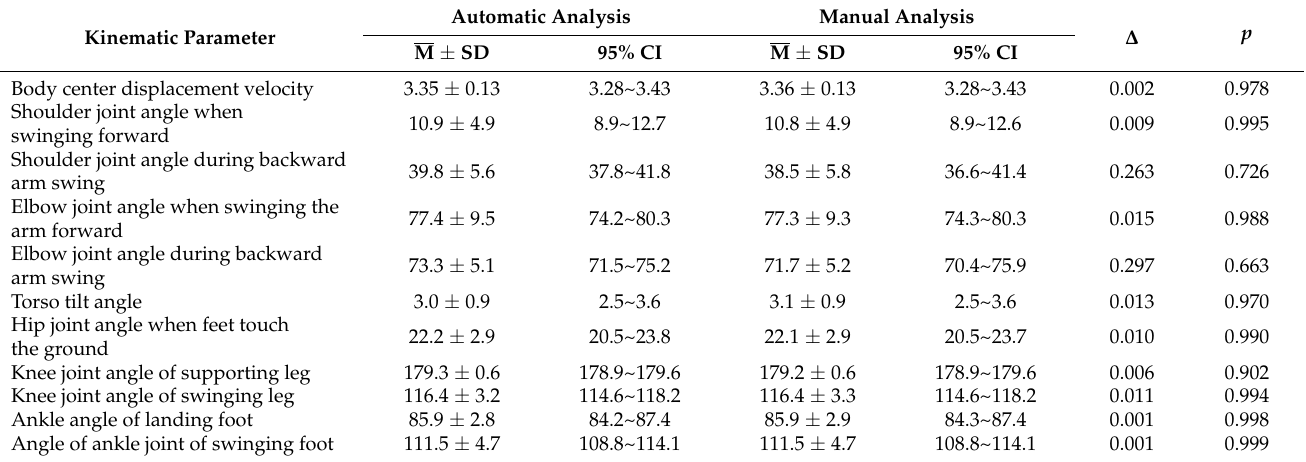
Table 5. Comparison of kinematic parameters of time of athletes’ left foot landing obtained via automatic analysis and manual